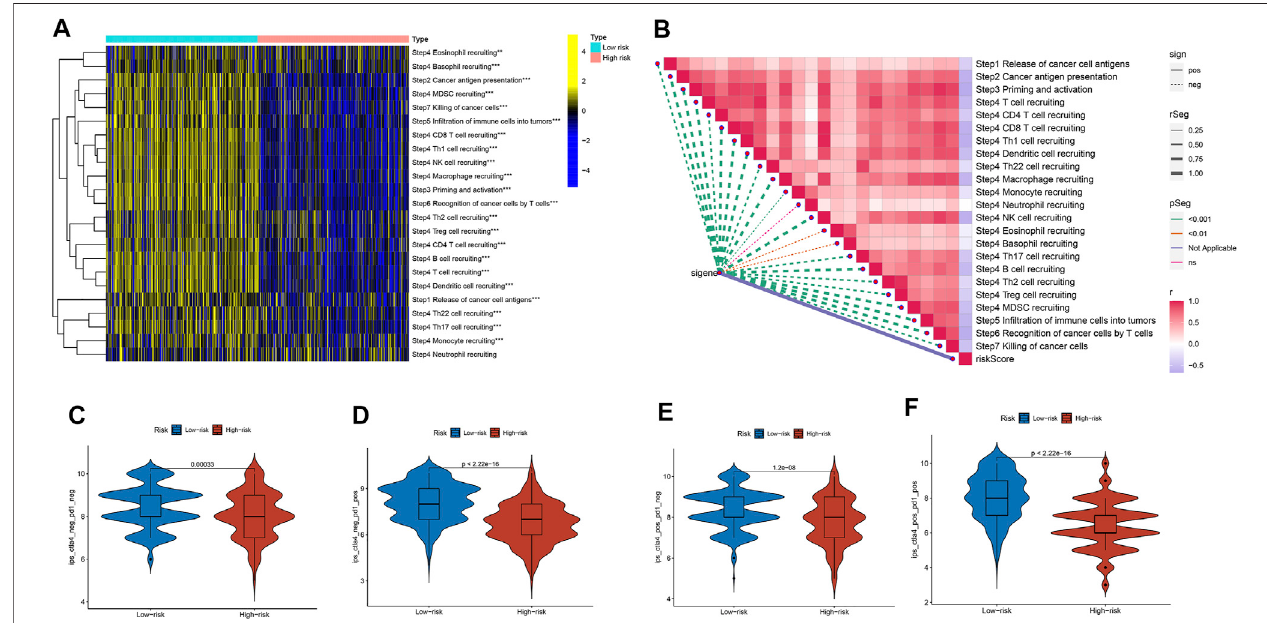
FIGURE 8 | The cancer immunity cycle and the immunotherapy response prediction among different risk groups. (A) The enrichment ofthe cancer immunity cycle between the two risk groups. (B) The cancer immunity cycle and the risk score correlation. (C,D,E,F) The IPS and risk score correlation.